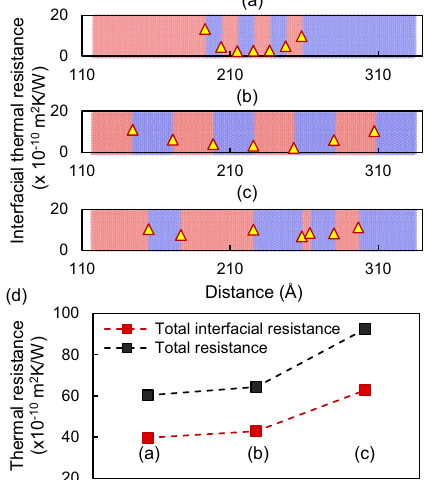
Fig. 4 Calculated thermal resistances at all interfaces (yellow triangles) in three different 40 UC RML structures. a RML with high κ identi fi ed by the ML-enabled search b 5-5 SL c RML with low κ identi fi ed by manual random search. The RML structures are underlaid for ease of visualization. d Comparison of the total interfacial thermal resistance (black squares) and total thermal resistance (red squares) for the three RML structures ( a – c